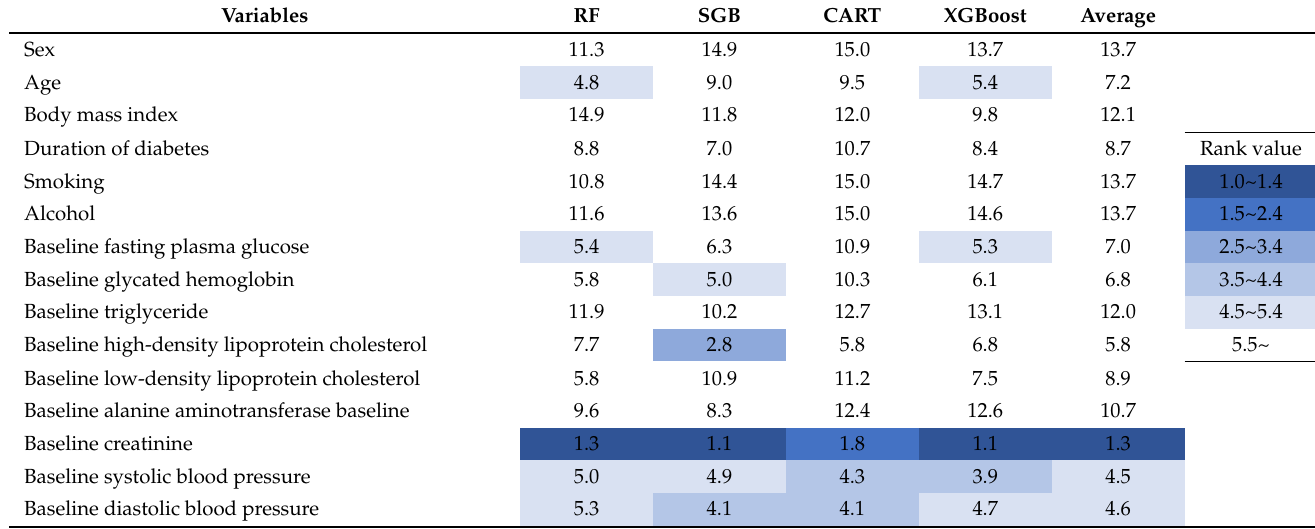
Table 6. Importance ranking of each risk factor using the four convincing